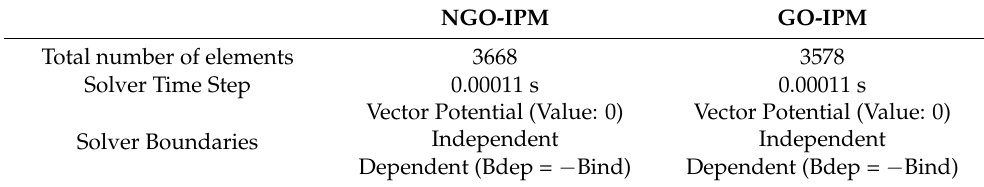
Table 2. Finite Element Numerical Calculation Detailed Settings.